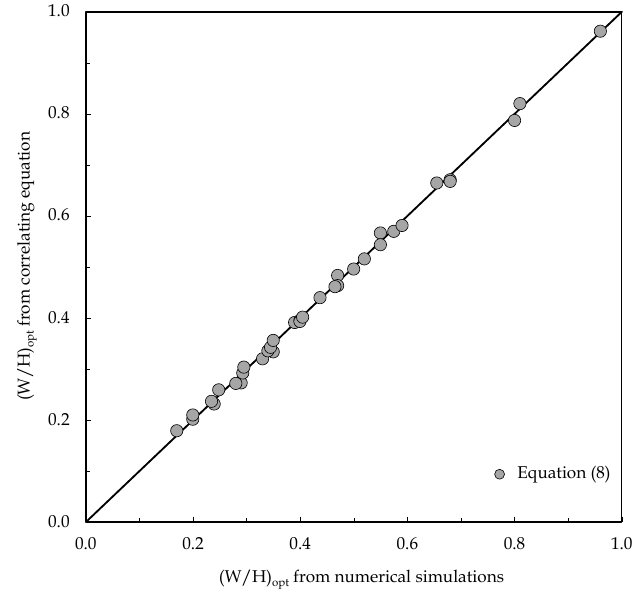
Figure 13. Comparison between Equation (8) and the numerical data obtained for ( W / H ) opt